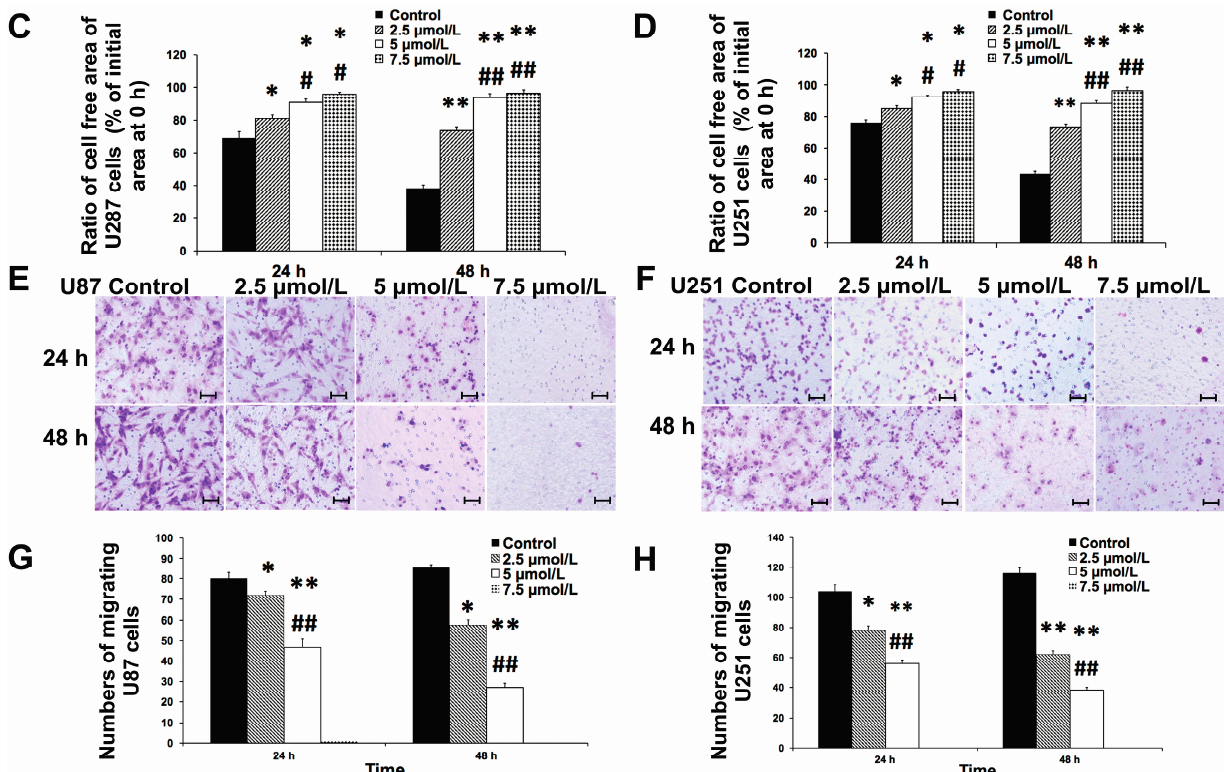
Figure 2. Effects of shikonin on the migratory capacity of glioma cells in vitro . U87 and U251 cells were treated with shikonin at 2.5, 5, and 7.5 μ mol/L for 0–48 h. Wound healing and Transwell in vitro migration assays were performed to investigate the changes of migratory capacity of glioblastoma cells under the treatment of shikonin. ( A ) Results of wound healing assay for U87 cells; ( B ) Results of wound healing assay for U251 cells; ( C ) Statistical analysis of wound healing assay for U87 cells. Doses of 2.5 and 5 μ mol/L significantly inhibited migration compared with the control group at 24 h. Both concentrations showed significant inhibition on migration at 48 h. However, 5 μ mol/L displayed even greater inhibition at 48 h; ( D ) Statistical analysis of wound healing assay for U251 cells; ( E ) Results of in vitro Transwell migration assay for U87 cells; ( F ) Results of Transwell in vitro migration assay for U251 cells. U251 cells were treated similarly to U87 cells; ( G ) Statistical analysis of migration assay for U87 cells. Doses of 2.5 and 5 μ mol/L significantly inhibited the migration ability of U87 cells compared with the control group at 24 h. A dose of 5 μ mol/L displayed even greater inhibition at 48 h; ( H ) Statistical analysis of migration assay for U251 cells. * p < 0.05, ** p < 0.01 vs. control group; # p < 0.05, ## p < 0.01 vs. 2.5 μ mol/L ( n = 5). Bar stands for 50 μ m. Original magnification of A , B : ×200; E , F :